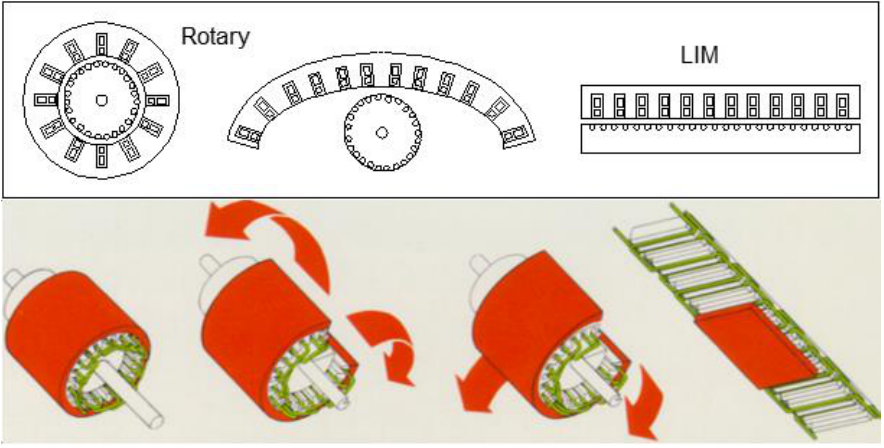
Figure 1. Conversion of rotary machine into LIM. Should the second primary be added to the single-sided LIM in Figure 1, a double- sided LIM would be formed. Depending on the relative length of the secondary and primary, the LIM can be categorized as a short-secondary (Figure 2) or a short-primary LIM.